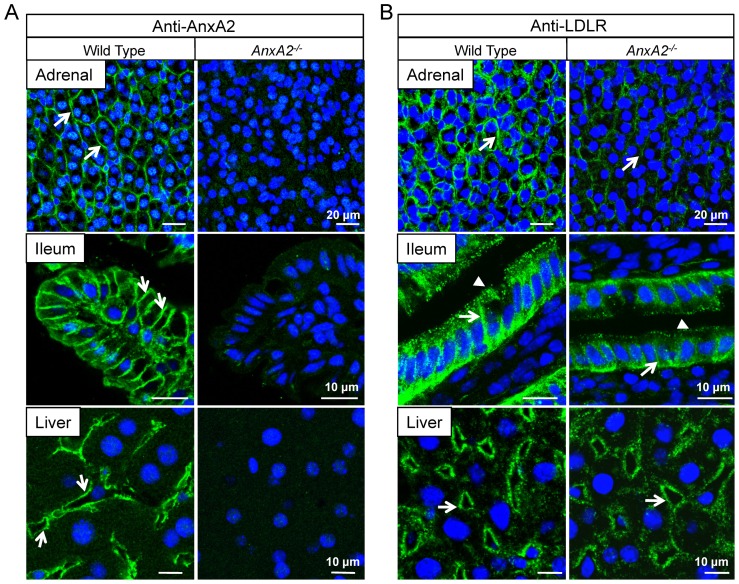
Immunofluorescence staining of LDLR and AnxA2 in tissues of WT and AnxA2
−/− mice.Frozen adrenal, ileum or liver tissue sections were fixed and incubated with anti-AnxA2 (A) or anti-LDLR (B) antibodies. Bound primary antibodies were revealed with species-specific Alexa-488 (green) secondary antibodies. Nuclei were counterstained with the blue fluorescent DNA dye DAPI. (A) Arrows in left panels depict the localization of AnxA2 along capillaries of the adrenal cortex (top panel), at the basolateral membrane of absorptive cells in the ileum (middle panel) and in capillaries of sinusoids in the liver (bottom panel) of WT mice. The absence of AnxA2 labelling in tissues of AnxA2−/− mice (right panels) demonstrates the specificity of the antibody. (B) Arrows in left panels depict the localization of LDLR at the cell surface of adrenal cortical cells (top panel), at the basolateral membrane and apical surface (arrowheads) of absorptive cells in the ileum (middle panel), and at the basolateral surface of hepatocytes facing sinusoids (bottom panel) of WT mice. The corresponding LDLR staining of AnxA2−/− mice tissues is significantly decreased in the adrenal and ileum while it shows less variation in the liver (right panels).